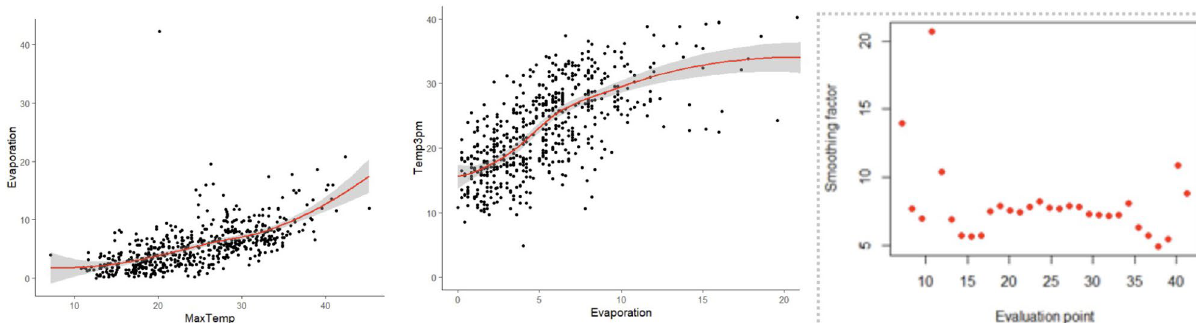
Figure 7. Boxplots between significant features.